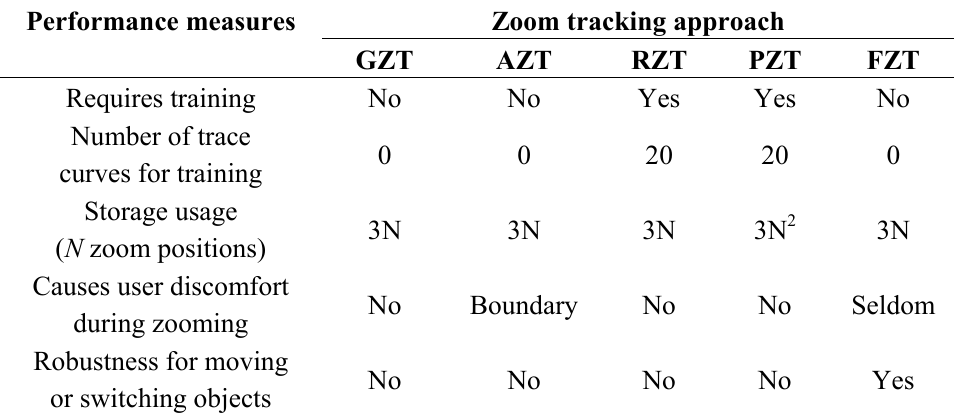
Table 7. Performance comparison of zoom tracking approaches.